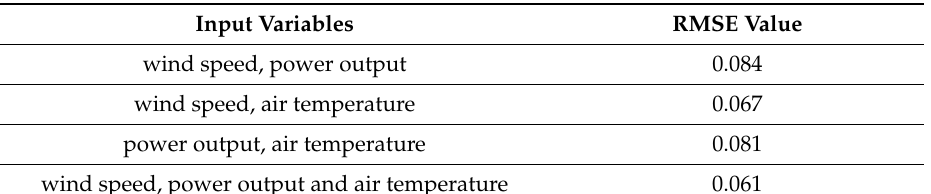
Table 1. The accuracy of the prediction models considering di ff erent input parameters. RMES: root mean square